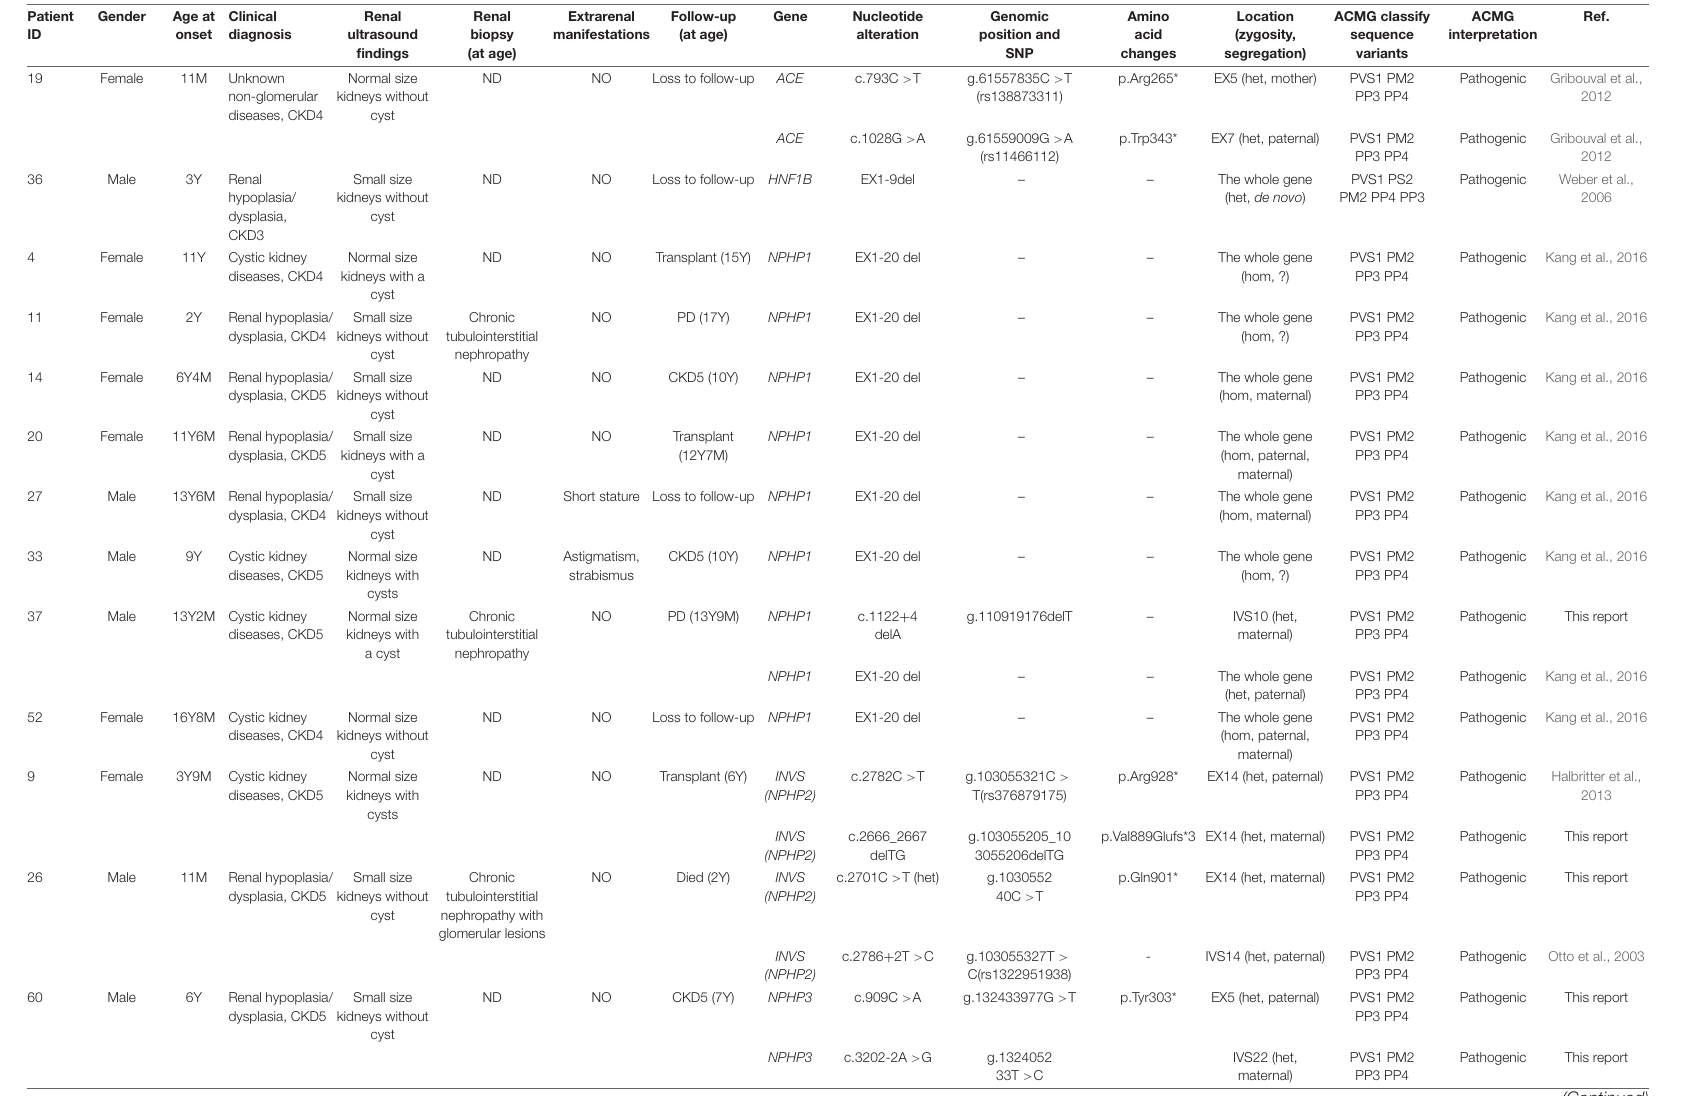
TABLE 2 | Pathogenic or likely pathogenic variants detected by targeted exome